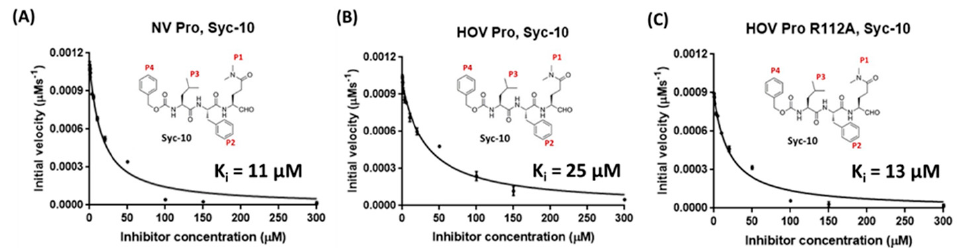
Figure 9. Peptidomimetic inhibitor exhibits differential inhibitory activity to proteases of different genogroups. ( A ) The inhibition potency of Syc-10 to GI.1. Syc-10 was identified and synthesized specifically to GI.1 protease. ( B ) The inhibition potency of Syc-10 to GII.4 protease is one-fold lower. ( C ) The inhibition potency of Syc-10 to a GII.4 Arg112 mutant.